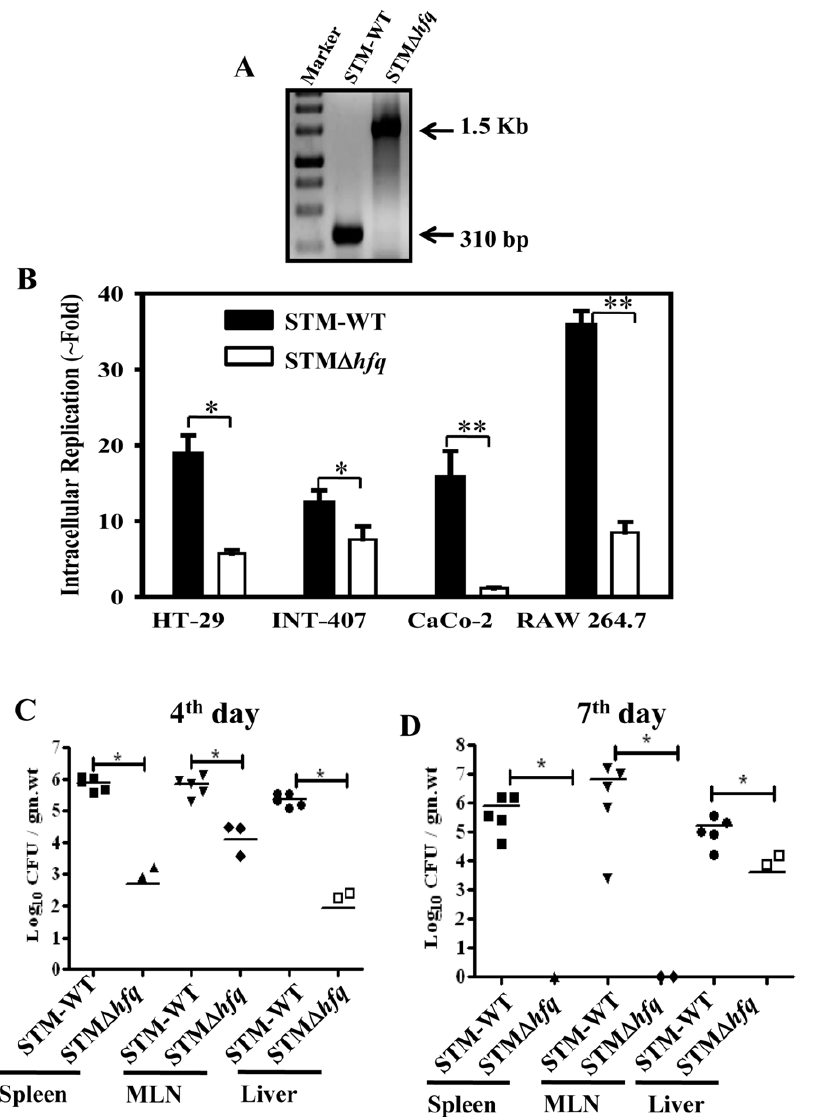
Figure 1. STM D hfq is highly attenuated invitro and invivo (A) Generation of STM D hfq by one step gene inactivation. Confirmatory PCR showing the presence of Kanamycin cassette (1.5 Kb) in STM D hfq . (B) Intracellular replication of STM-WT and STM D hfq strains in INT-407, HT-29, CaCo-2 and RAW 264.7 cell lines. Cells were infected with the STM D hfq or STM-WT at an MOI of 10. Data shows fold increase from 2 h to 16 h. All the experiments were done in triplicate. (C&D) Organ loads of STM-WT and STM D hfq . Two groups of mice (5 each) were infected with 10 7 CFU/mouse orally and sacrificed on day 4 (C) and day 7 (D) of post infection. Bacterial counts in spleen, MLN and liver were shown as CFU/gm.wt with standard errors. Plots are representative of two independent experiments with similar results. Statistical significance was defined as follows: (*p , 0.05; ** p , 0.005) (Student’s t test & Mann-Whitney U test).